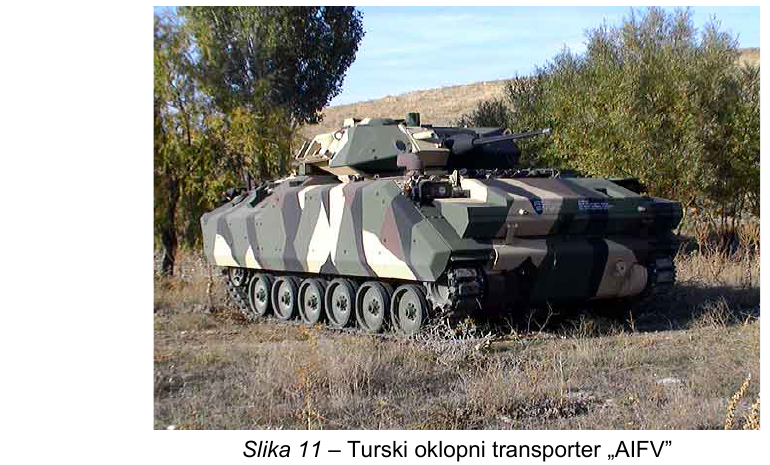
Figure 11 – Turkish armoured vehicle